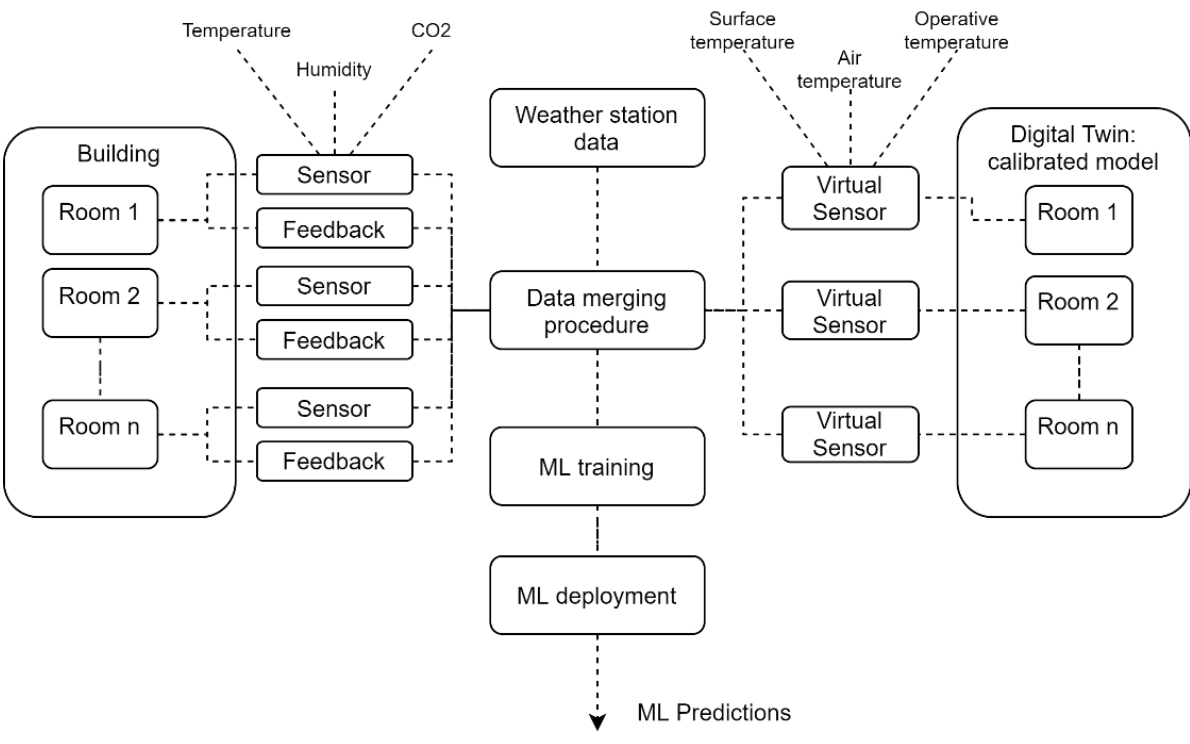
Figure 2. Data merging procedure.